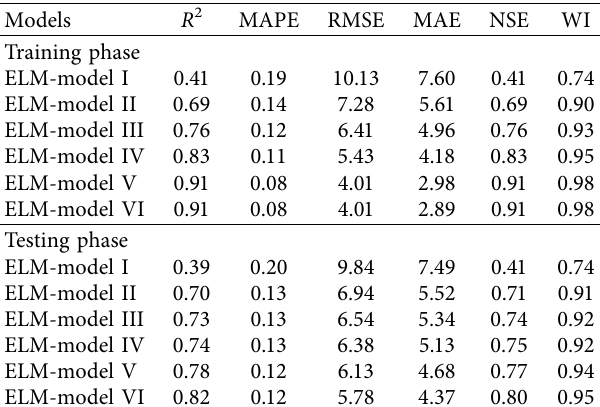
Table 11: Statistical measurements for ELM model over training and testing phase for all input combinations.